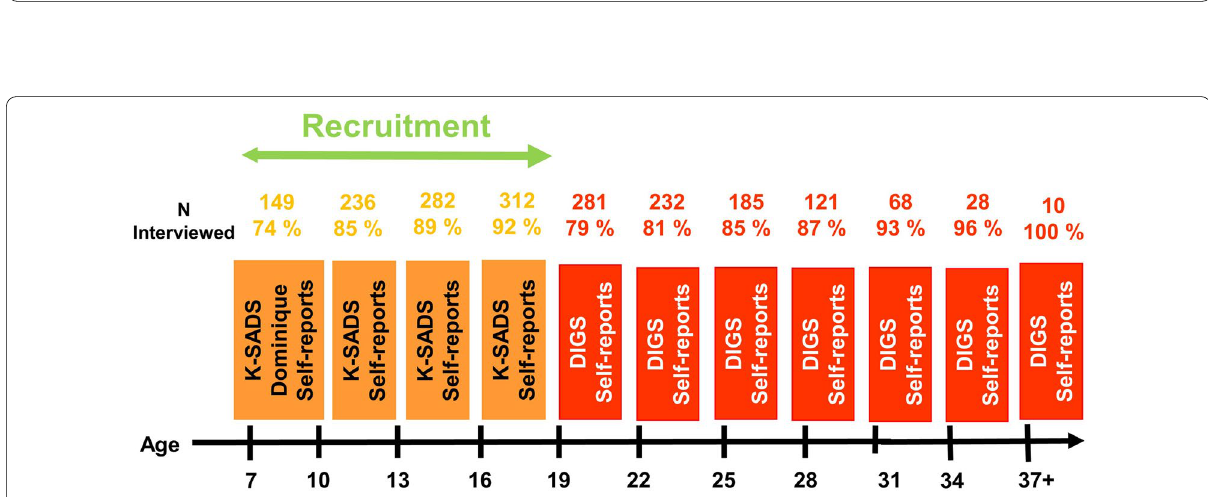
Fig. 2 Assessments in offspring (n